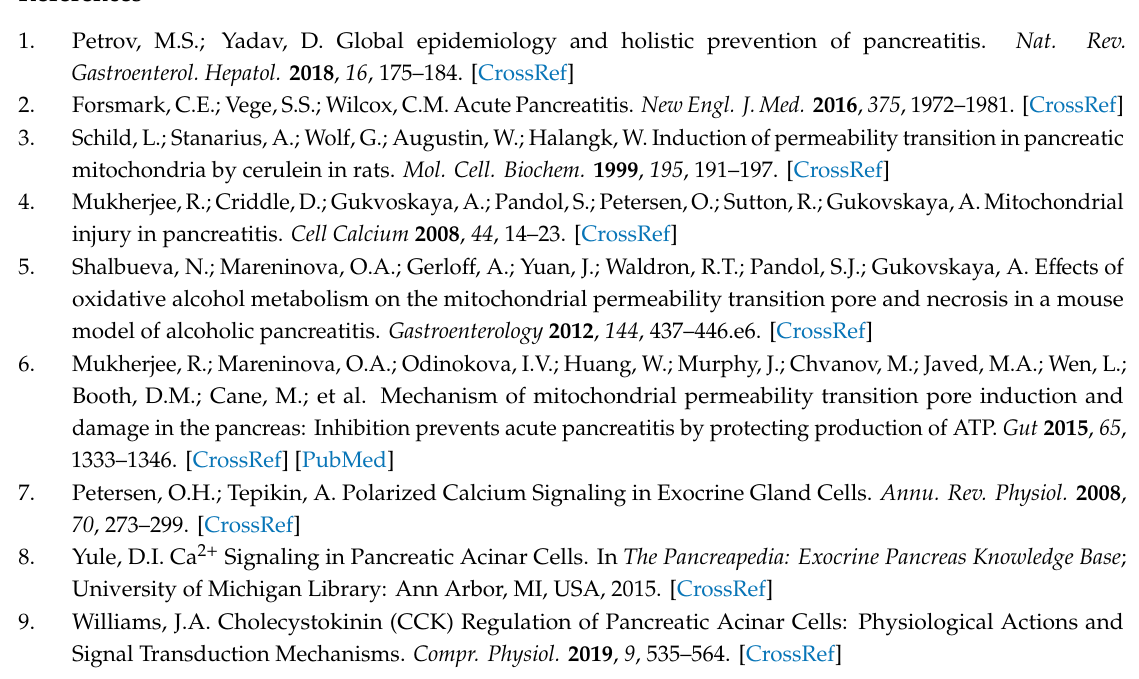
Figure S1: Western blot analysis of pancreata from MCU − / − and MCU +/+ mice and the distribution of MtRCaMP fluorescence in pancreatic acinar cells. Figure S2: Mitochondrial Ca 2 + responses to palmitoleic acid (POA) in acinar cells isolated from MCU − / − and MCU +/+ mice. Figure S3: Amplitudes of CCK-induced changes in NAD(P)H fluorescence, FAD fluorescence and NAD(P)H / FAD ratio in acinar cells isolated from MCU − / − and MCU +/+ mice. Figure S4: Amplitudes of CCK-induced changes in oxygen consumption rates (OCR) and areas under the peaks of CCK